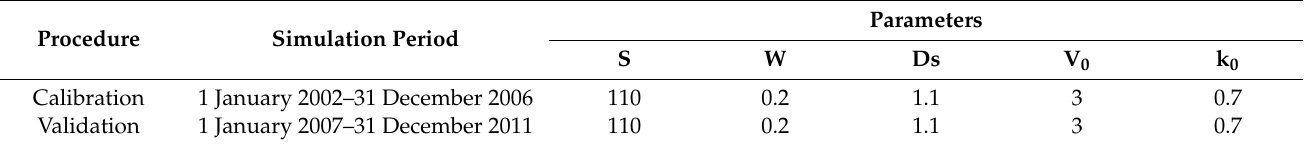
Table 3. Optimal parameter values of the ATHYS